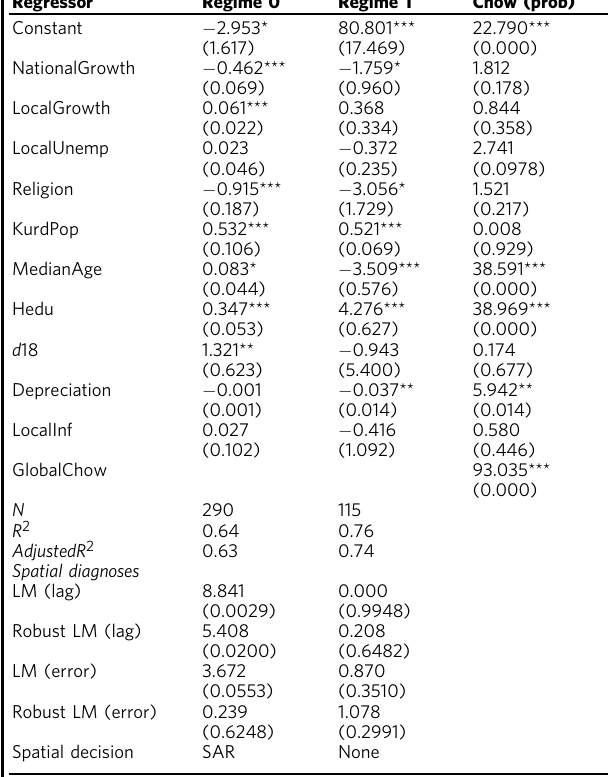
Table 4 Spatial regime results for the pro-Kurdish